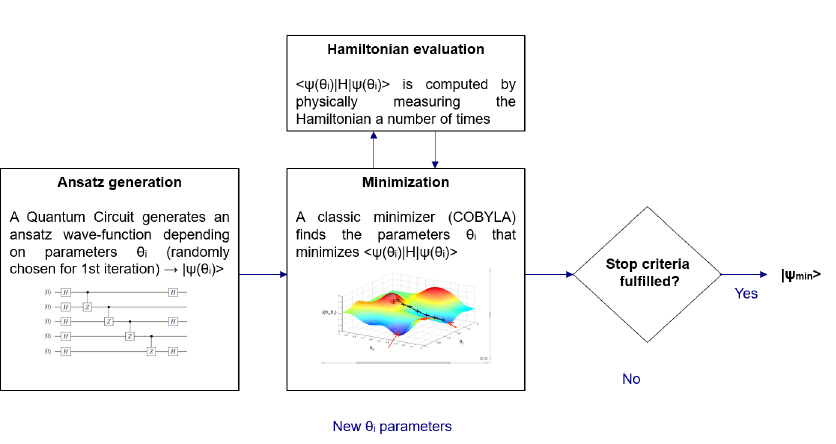
Figure 1: Diagram that shows the steps VQE algorithm take and their